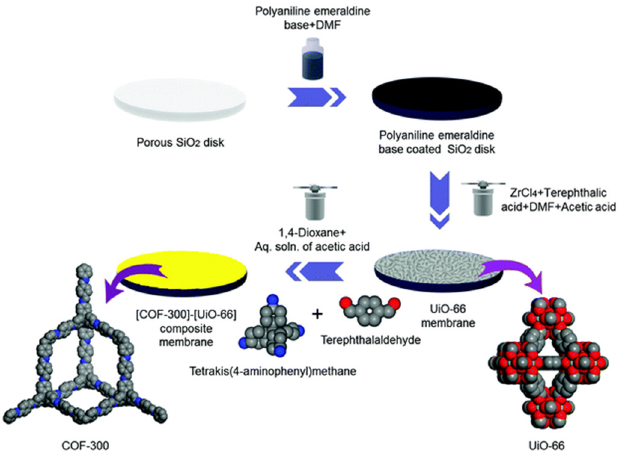
Figure 10. Strategy for the fabrication of the [COF-300]-[UiO-66] composite membrane. Zirconium, carbon, nitrogen, and oxygen atoms are shown as cyan, grey, blue, and red, respectively. Hydrogen atoms are omitted for clarity. Reprinted with permission from [94], The Royal Society of Chemistry, Copyright (2018).